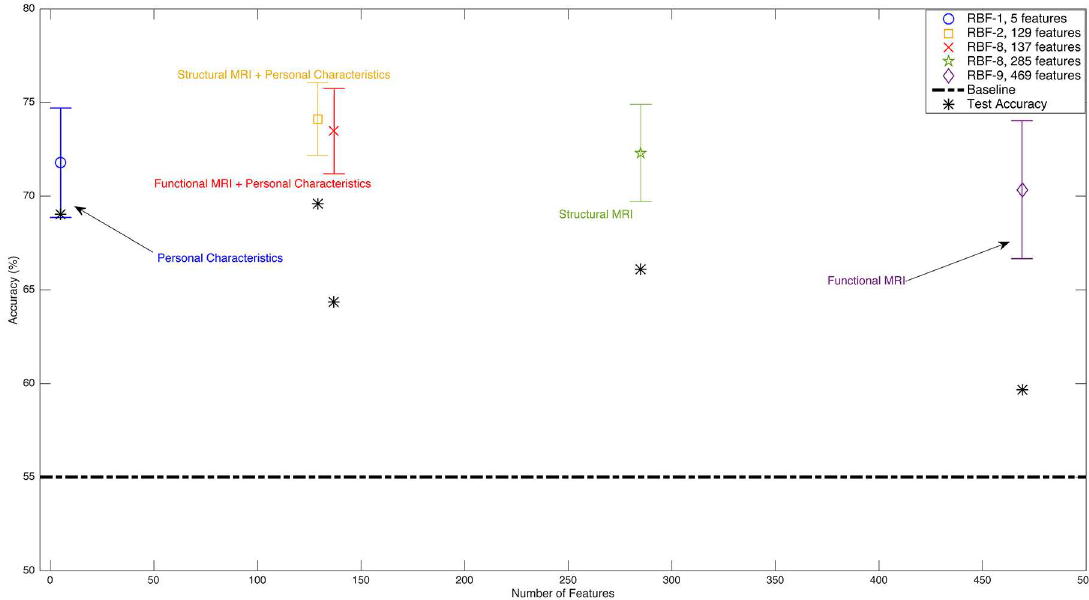
Fig 7. Summary of ADHD-200 dataset classification results. The black horizontaldotted line shows the baselinechance accuracyof the test set. Each vertical bar shows the mean and range of the cross validationresults for the selectedbase learner (L) and feature set (FS * (L)) on the trainingset, as producedwith MHPC (Algorithm1). The blue asterisks * show the accuracy of each classifier on the hold-outset. The classifiers on the x-axis are orderedby the types of features they used, including variouscombinations of structural MRI, functionalMRI, and personalcharacteristic data. The legendalso identifies the actual classifier used. This figure is best viewedin